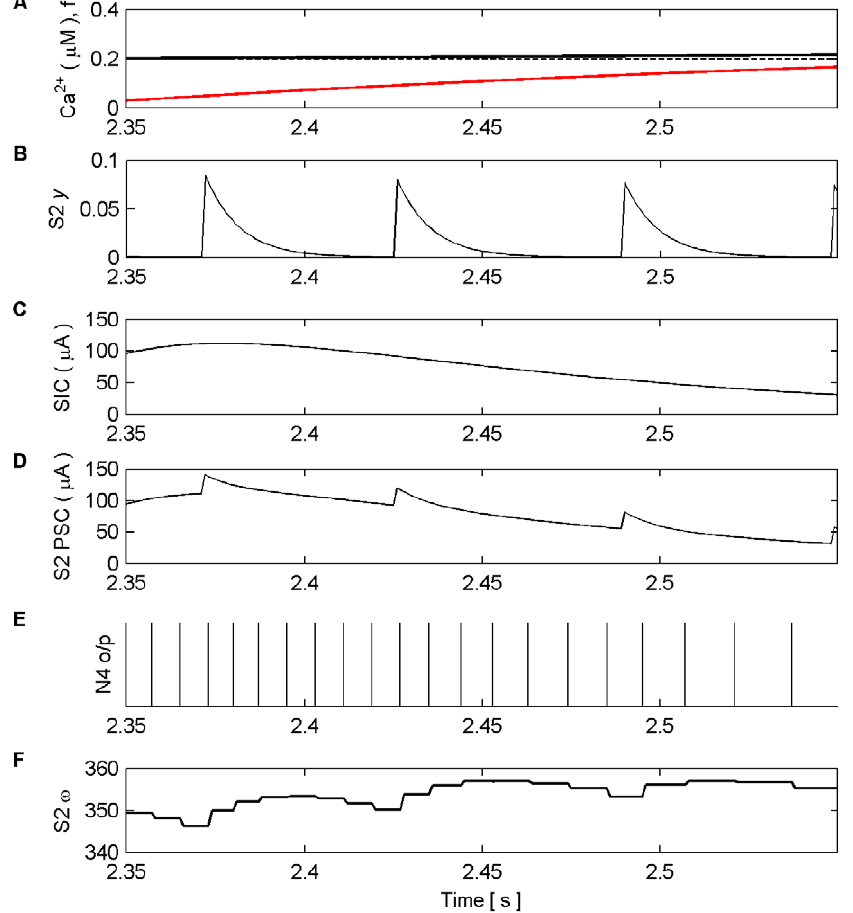
Figure 8. Synaptic Plasticity in the AN Model (2.35 s–2.55 s). (A) Ca 2 + oscillation resulting from pre-synaptic stimulation of S1 by N1, including the gating function f (red) and Ca 2 + threshold (dashed). (B) neurotransmitter ( y ) released by S2 as a result of presynaptic stimulation by N2. (C) SIC induced by the release of glutamate from the astrocyte when Ca 2 + levels cross the Ca 2 + threshold (crossing point not shown). (D) PSCs at S2, comprising EPSCs elicited by the neurotransmitter released by N2 and the SIC. (E) N4 output firing activity. (F) Synaptic weight ( v ), Note that the weight either potentiates or depresses based on the temporal order of the pre and post neural activity.